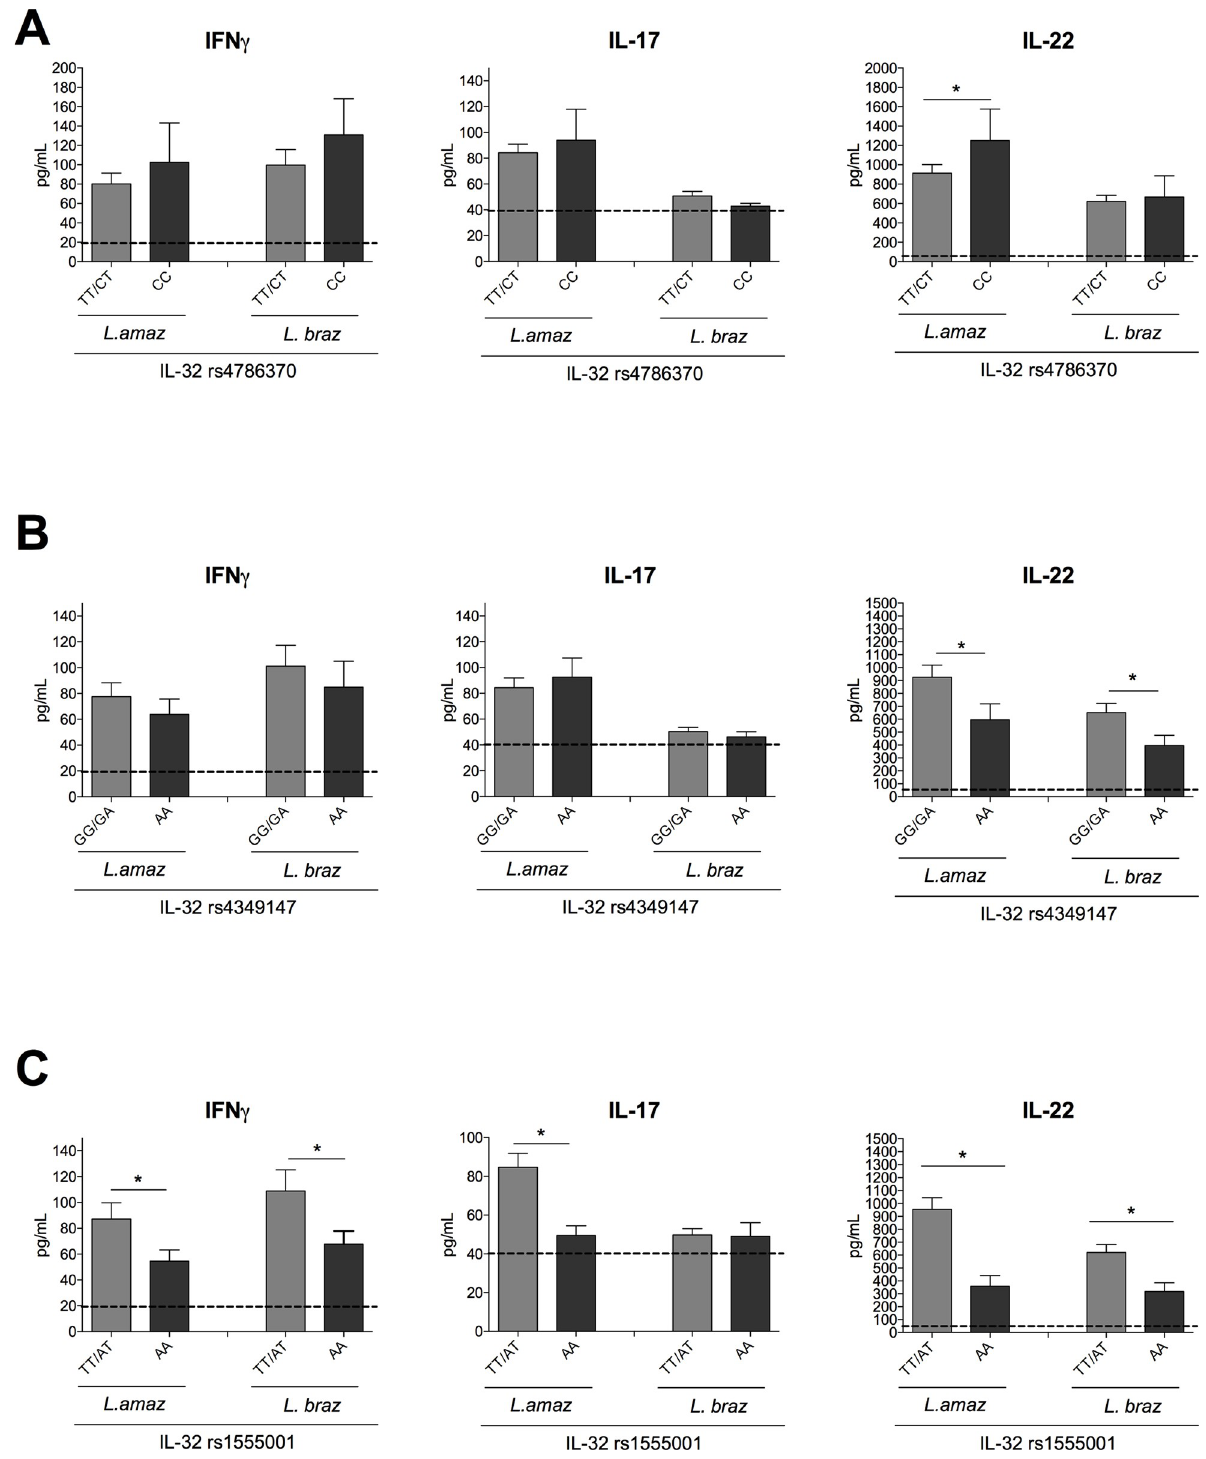
Fig 5. PBMCs from healthy donors from the 200FG cohort were stimulated with lysates (50 μ g/ mL) of L . amazonenis and L . braziliensis for 7 days. Levels of IFN γ , IL-17 and IL-22 were measured by ELISA. Cytokine levels were stratified for the different genotypes for (A) IL-32 rs4786370 (TT/CT n = 139; CC n = 25), (B) rs4349147 (GG/GA n = 140; AA n = 23), (C) rs1555001 (TT/AT n = 146; AA n = 17). Dotted line represents the basal level of cytokine production in the RPMI control. The data shown are the mean ± SEM, � p < 0.05 (TT/CT vs CC; GG/GA vs AA; TT/AT vs AA, respectively, Mann-Whitney U